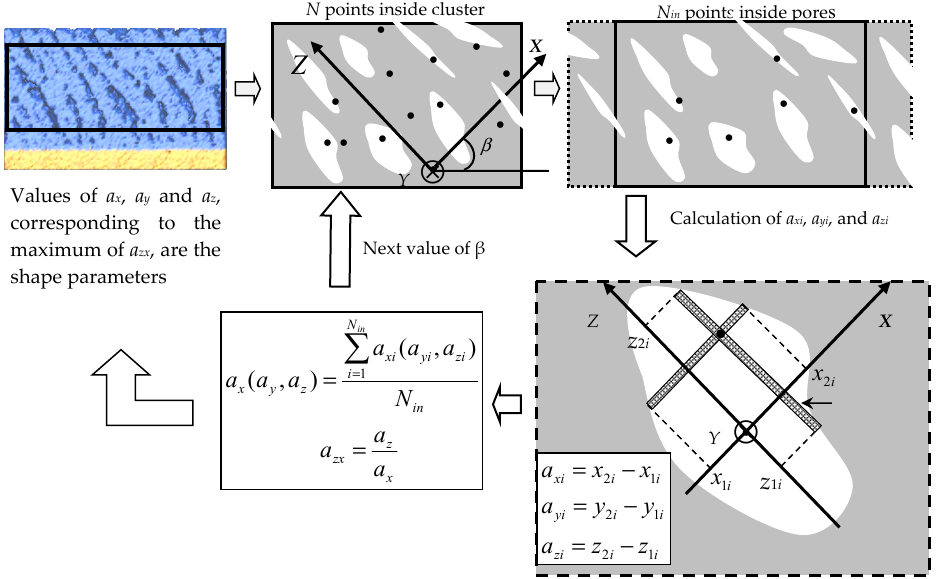
Figure 3. The flowchart for calculating the shape parameters a x , a y and a z by Monte Carlo averaging of pore dimensions a xi , a yi and a zi by volume. The β angle is chosen so as to maximize the a z / a x ratio.